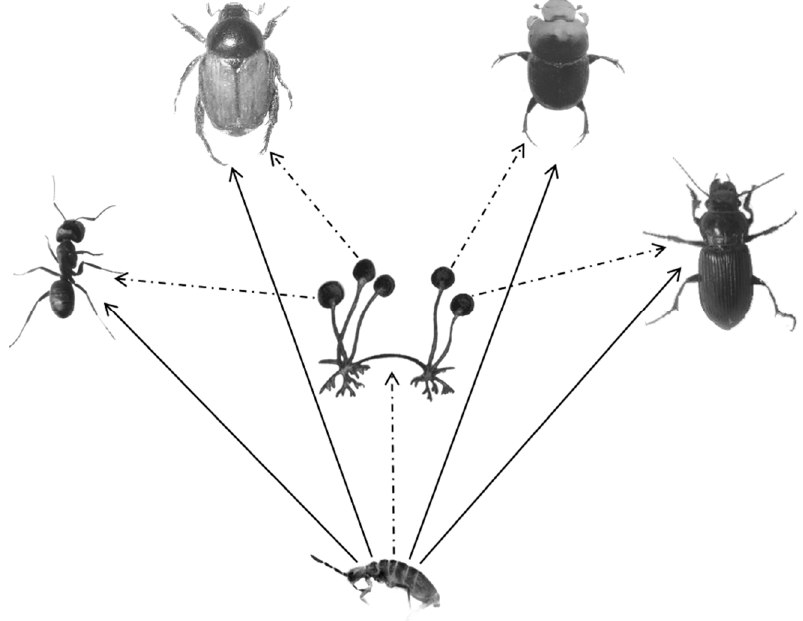
Figure 3. Each of the insects were a dominant soil organism in the same habitat as an epigeic collembolan. The solid line with an arrow indicates that the collembolan can directly digest the four types of insects, and the dotted line with an arrow indicates that the collembolan may consume microorganisms (such as fungi ( Rhizopus sp., Alternaria sp., Penicillium sp., and Aspergillus sp.) and bacteria ( Bacillus sp1. and Bacillus sp2.) in an indirect manner.